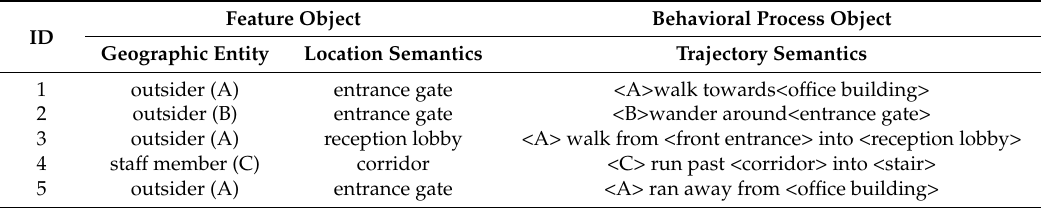
Table 3. Change semantics of the behavioral process object in